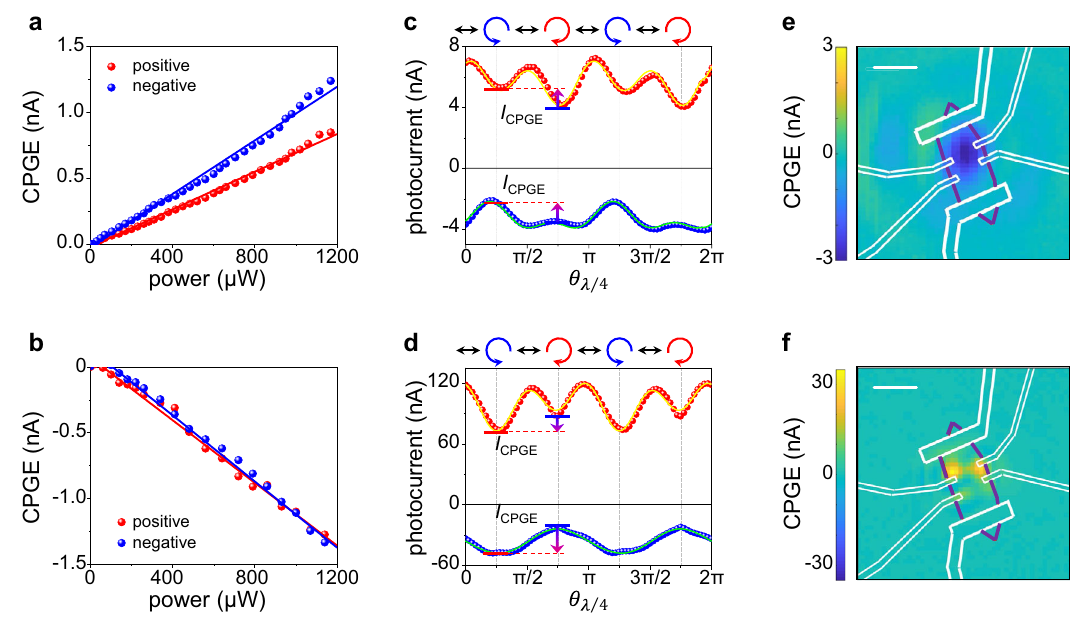
(blue) responses on the T e device. e The spatial-resolved CPGE under 10.6- μ m excitation on the Te device. The scale bar is 10 μ m. b , d , f Experiments carried out under 4.0- μ m excitation.